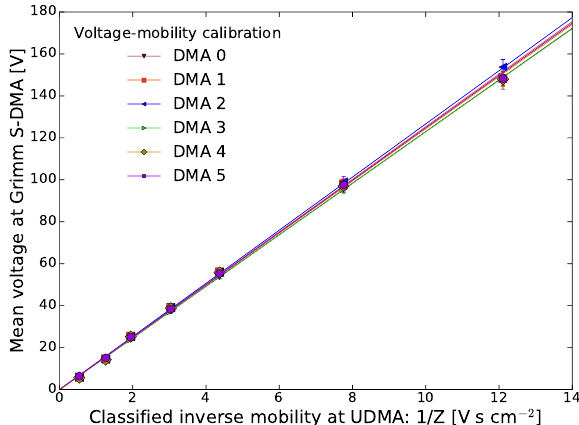
Figure 3. Calibration of the voltage–mobility relation for all six Grimm S-DMAs used. The mean voltage of least-squares fits to the relative FCE response downstream of the six Grimm S-DMAs is plotted against the classified inverse mobility of the UDMA. The linear least-squares fit has only one free parameter: the effective classification length of the Grimm